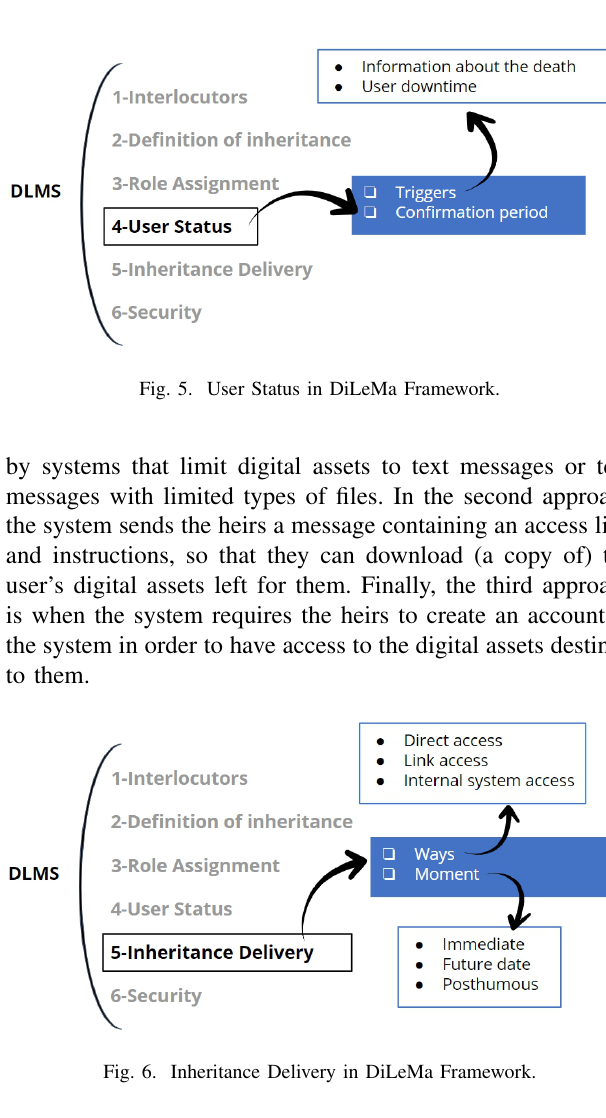
Fig. 6. Inheritance Delivery in DiLeMa